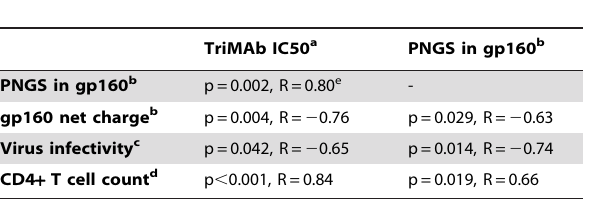
Table 2. Correlations between TriMAb sensitivity, Env PNGS, Env net charge, virus infectivity and patients CD4 + T cell count.